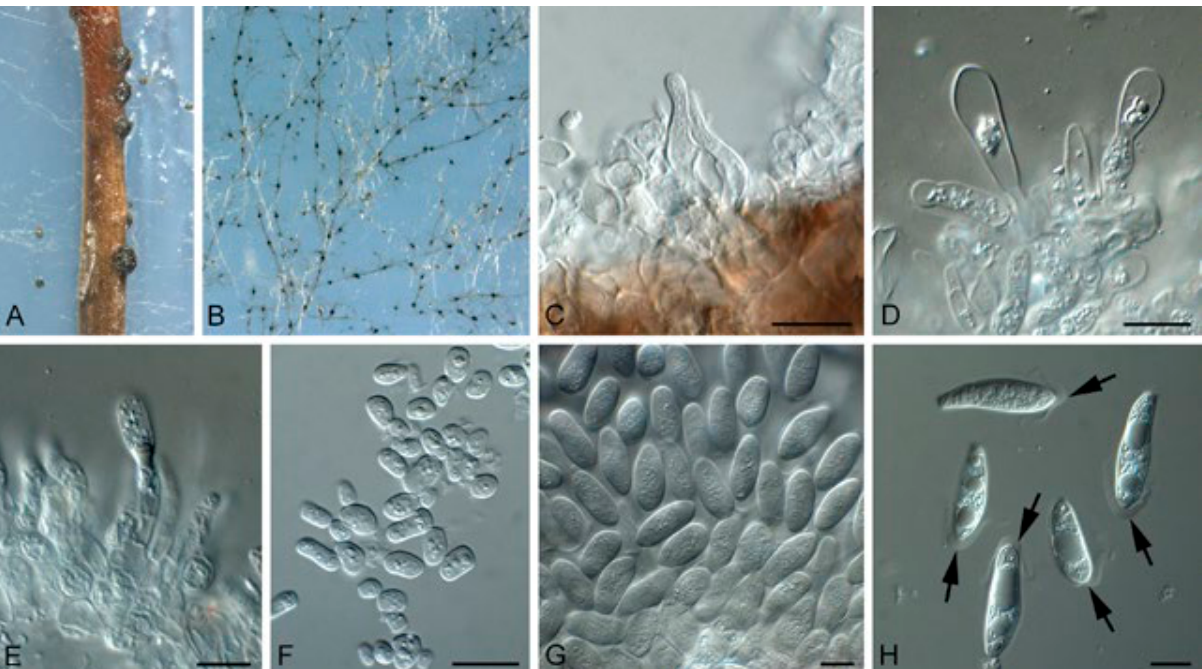
Figure 4. Macrophomina phaseolina (CBS 205.47). Pycnidia forming on pine needle agar. B. Sclerotia on tap water agar. C–E. Conidiogenous cells. F. Microconidia. G, H. Macroconidia with apical appendages (arrows). Scale bars = 10